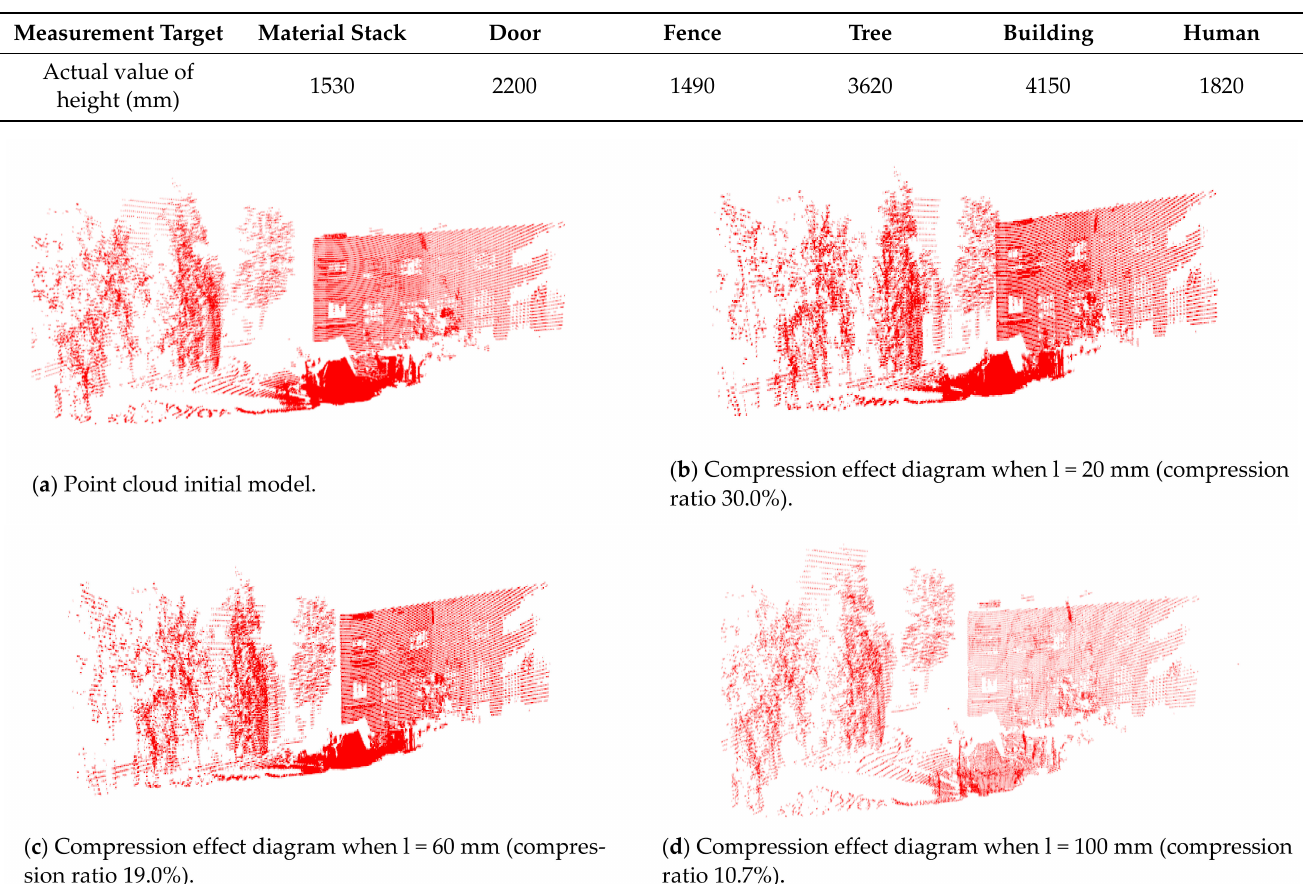
Table 1. Comparison of measurement size and actual size of marked point cloud compressed.